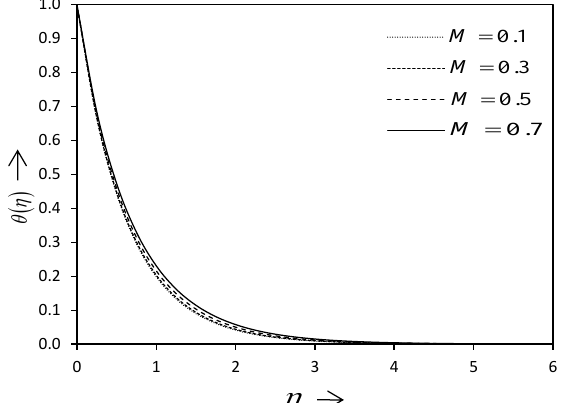
Figure 7. Temperature profiles against  for various values of M with 1 . 0 , 0 . 1  A S